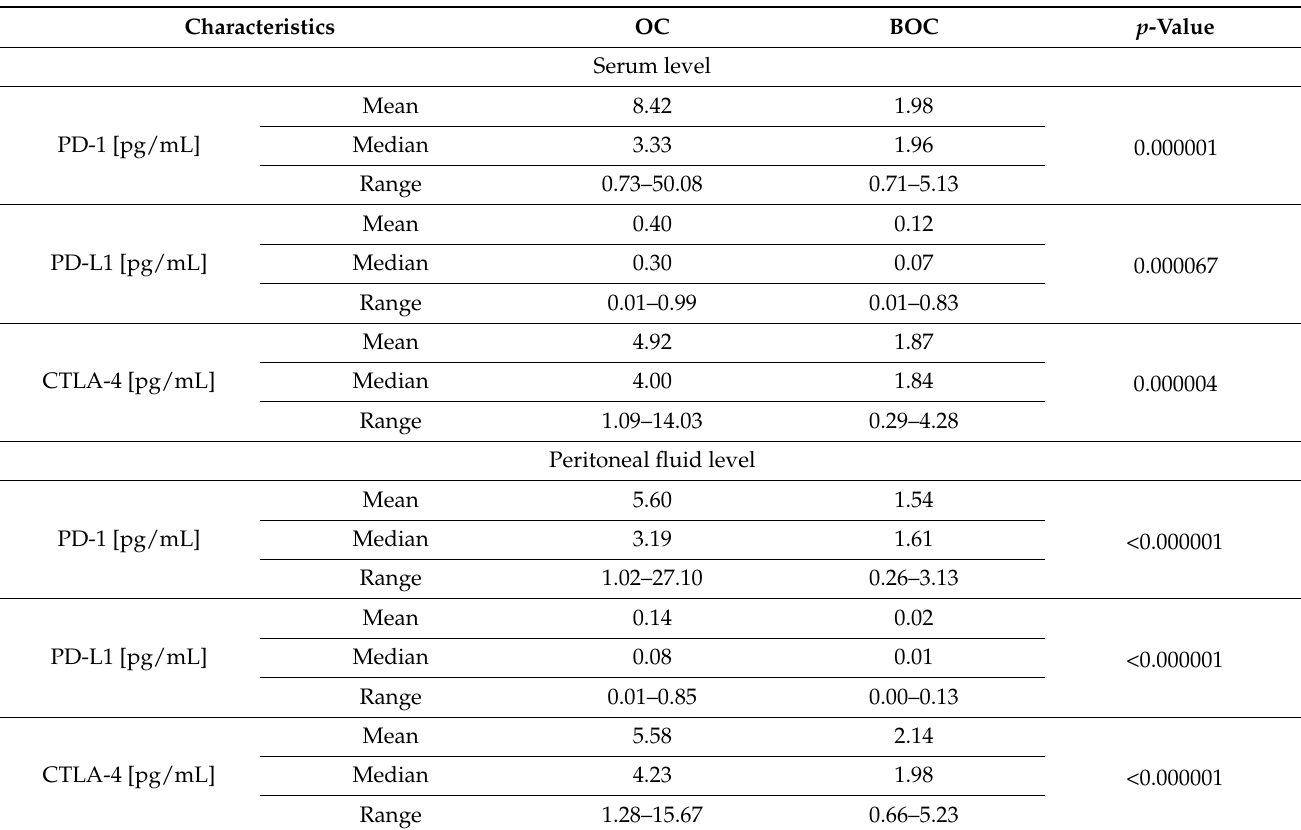
Table 3. Levels of serum and peritoneal fluid concentrations of the studied proteins in the OC group and the BOC group.